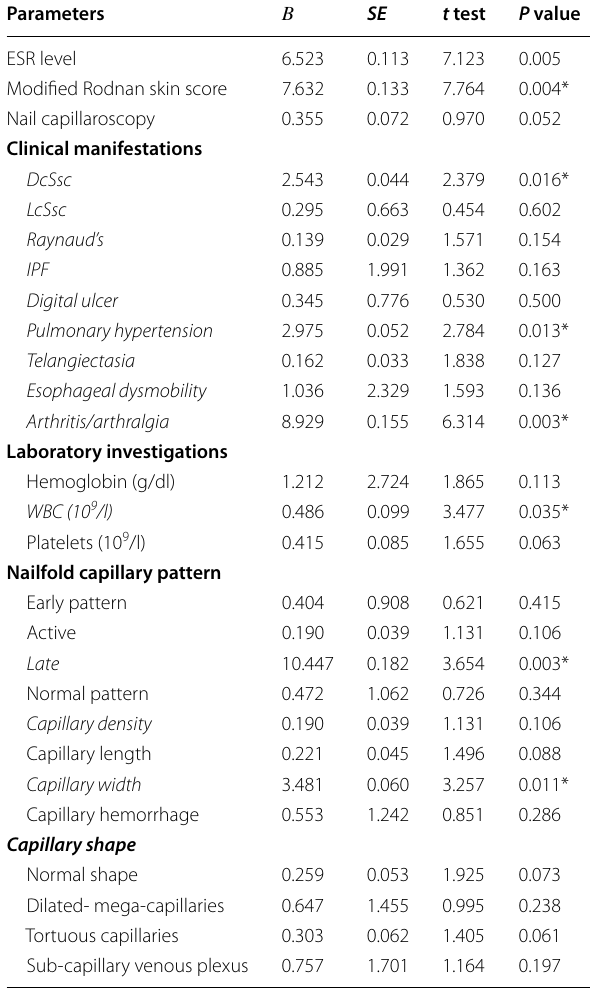
Table 4 Best fitting multiple linear regression models for the MASEI score